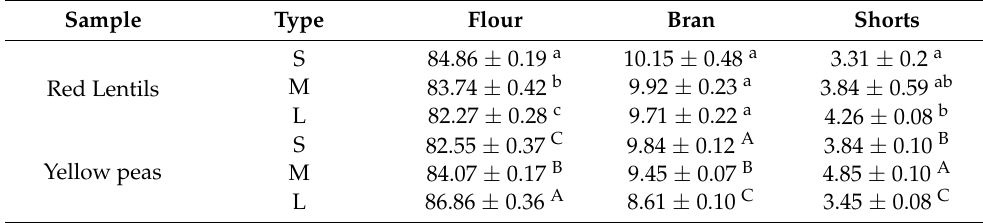
Table 2. Milling yields (% as -is) of red lentils and yellow peas from roller mill.